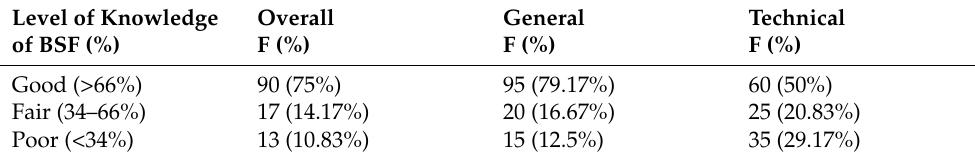
Table 1. Respondents’ knowledge of BSF (technicality and benefits).